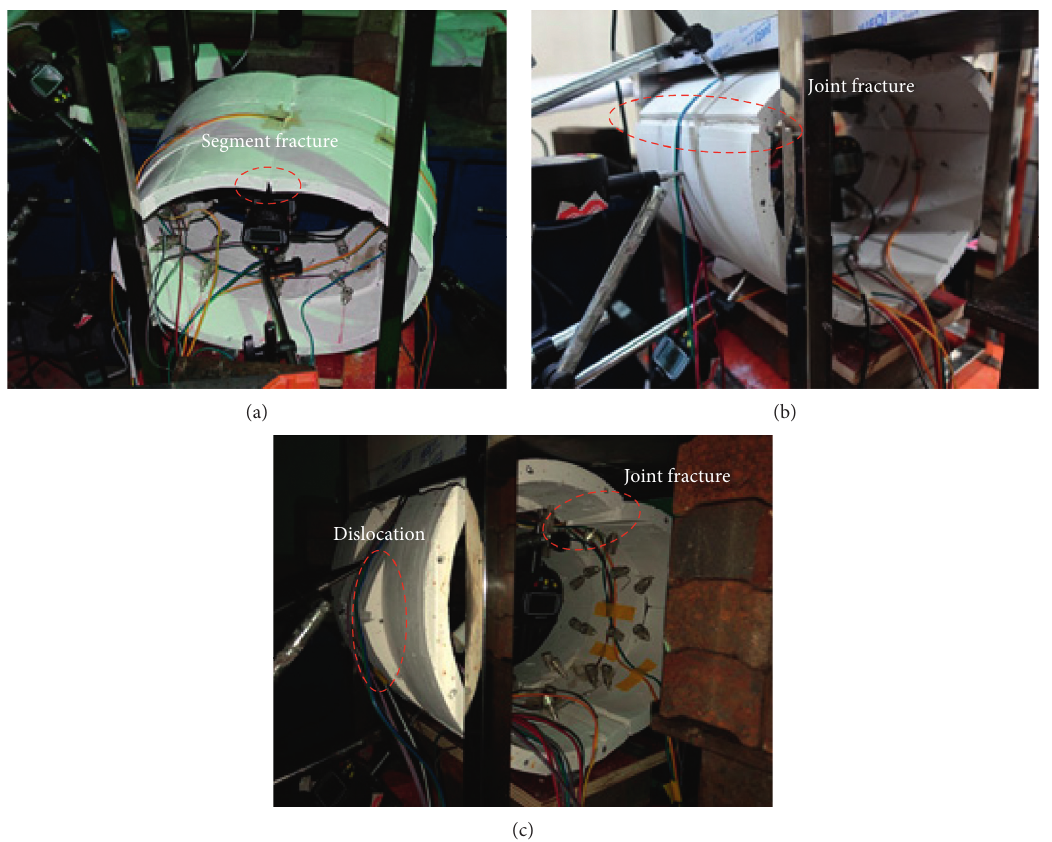
Figure 15: Failure of the lining structure. (a) Uniform rings. (b) Straight-jointed rings. (c) Stagger-jointed